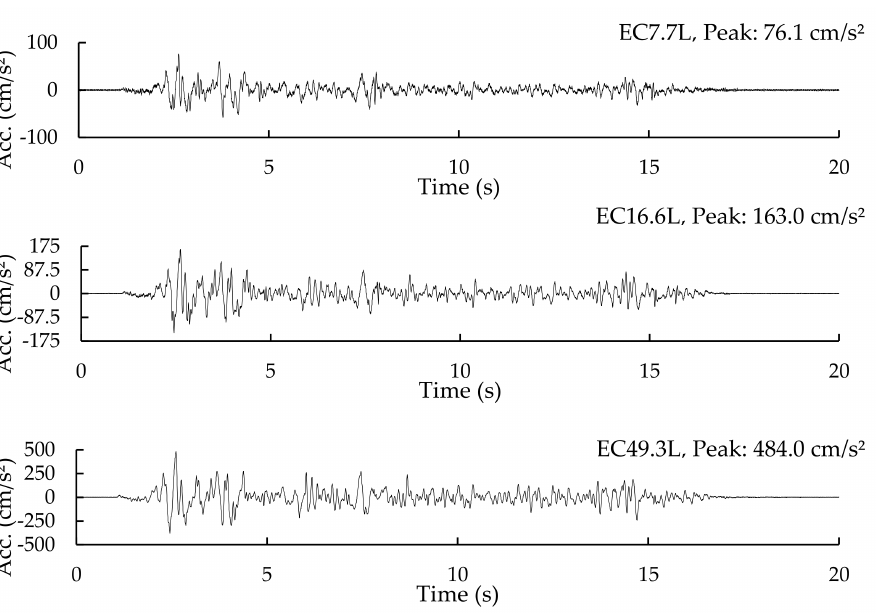
Figure 9. Elevation view of setback experimental test specimen: ( a ) front view, ( b ) side left view, and ( c ) side right view.